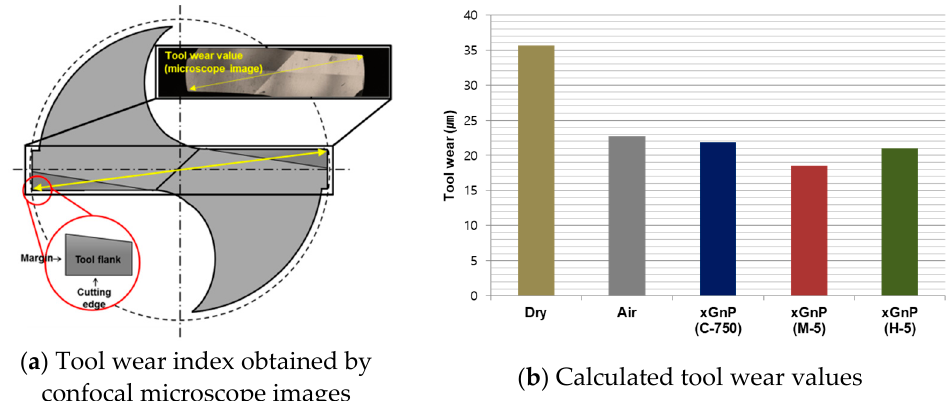
Figure 17. Tool wear index obtained by confocal microscope images and tool wear values.